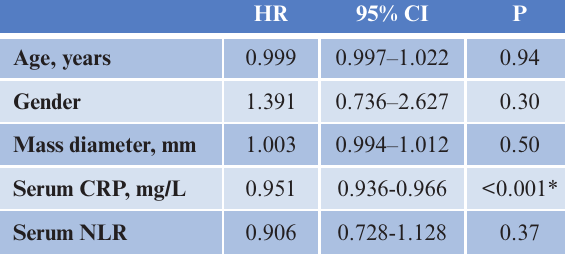
Table 6: Multivariate Cox Proportional Hazard Regression Analysis of the parameters age, gender, mass diameter and, serum CRP and NLR levels for prediction of the malign pathology after renal mass